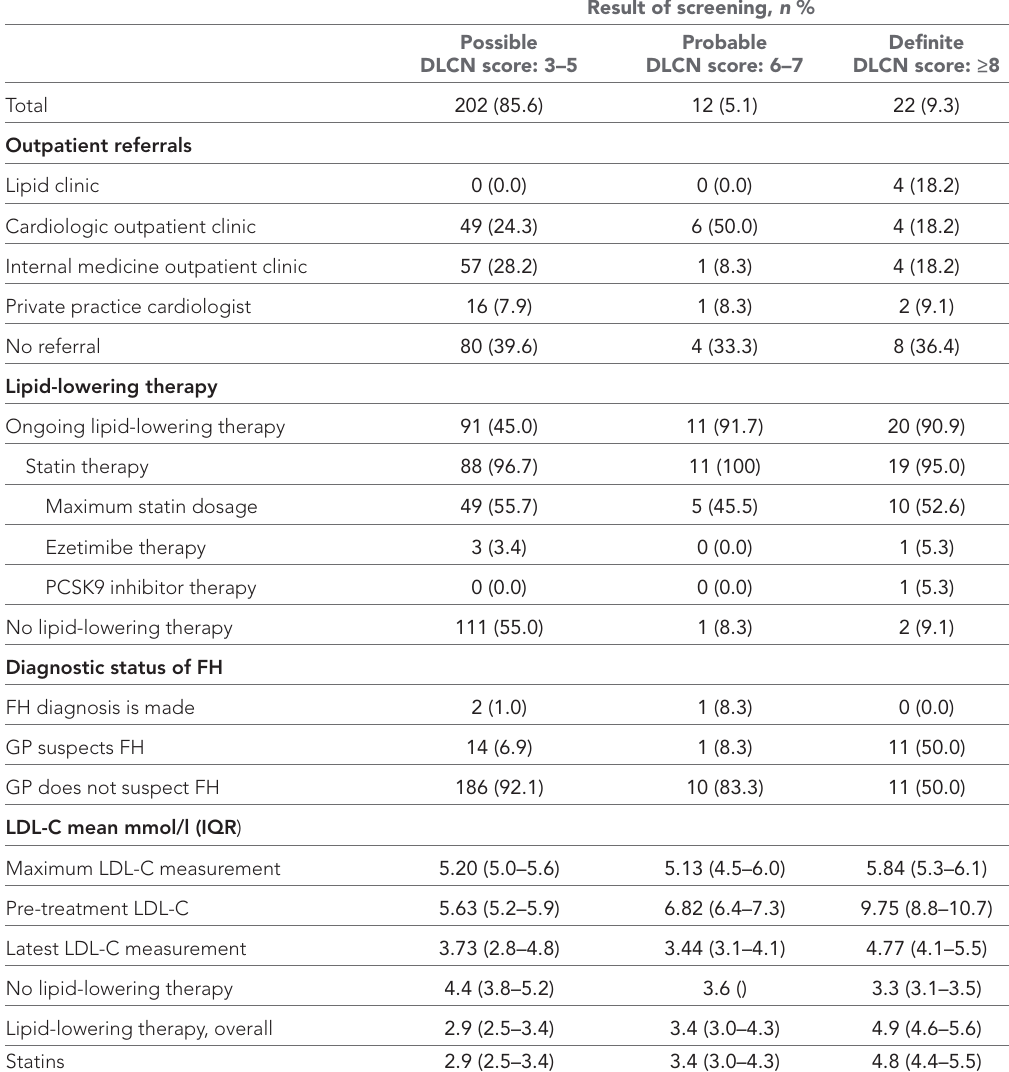
Table 3 Management of patients with potential FH, N =